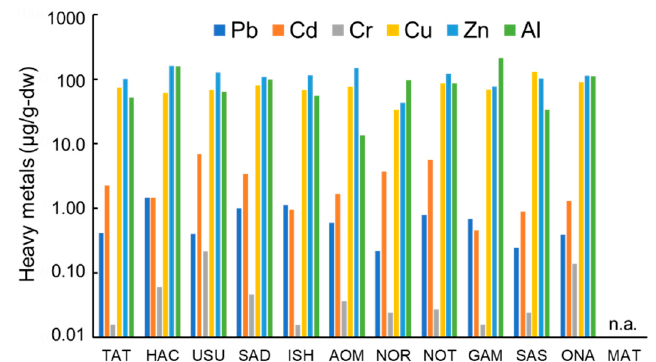
Figure 1. Detected concentration of individual heavy metals in wharf roach ( µ g/g-dw) collected from 11 sampling sites (n.a.: not available).